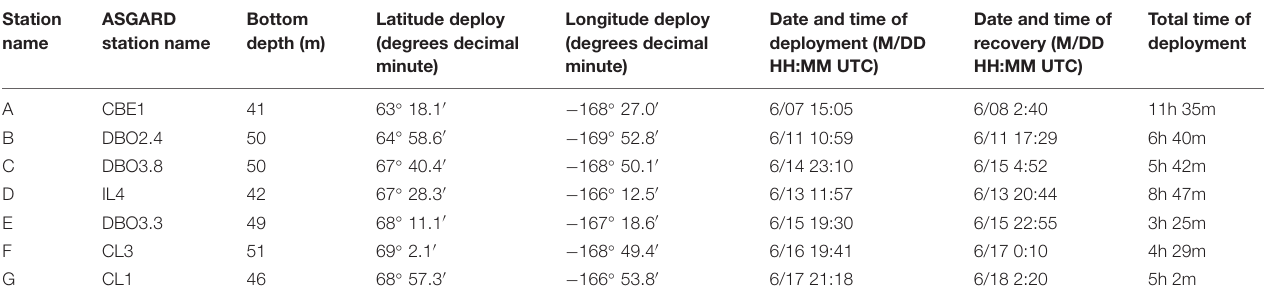
FIGURE 1 | Spatial patterns of sinking particulate organic carbon fluxes on the Pacific Arctic shelf in June 2018. Drifting sediment trap measurements are depicted relative to the diameters of the circles, while moored sediment traps fluxes are shown as the length of the squares. Colored lines represent sea ice extent (Fetterer et al., 2017), where the 2018 June median ice extent (maroon) is compared with the 1981–2010 median June baseline (purple) and the record breaking 2018 maximum ice extent (olive) is compared with the 1981–2010 median winter maximum (teal). TABLE 1 | Location and duration of drifting sediment trap deployments 30 m below the sea surface in